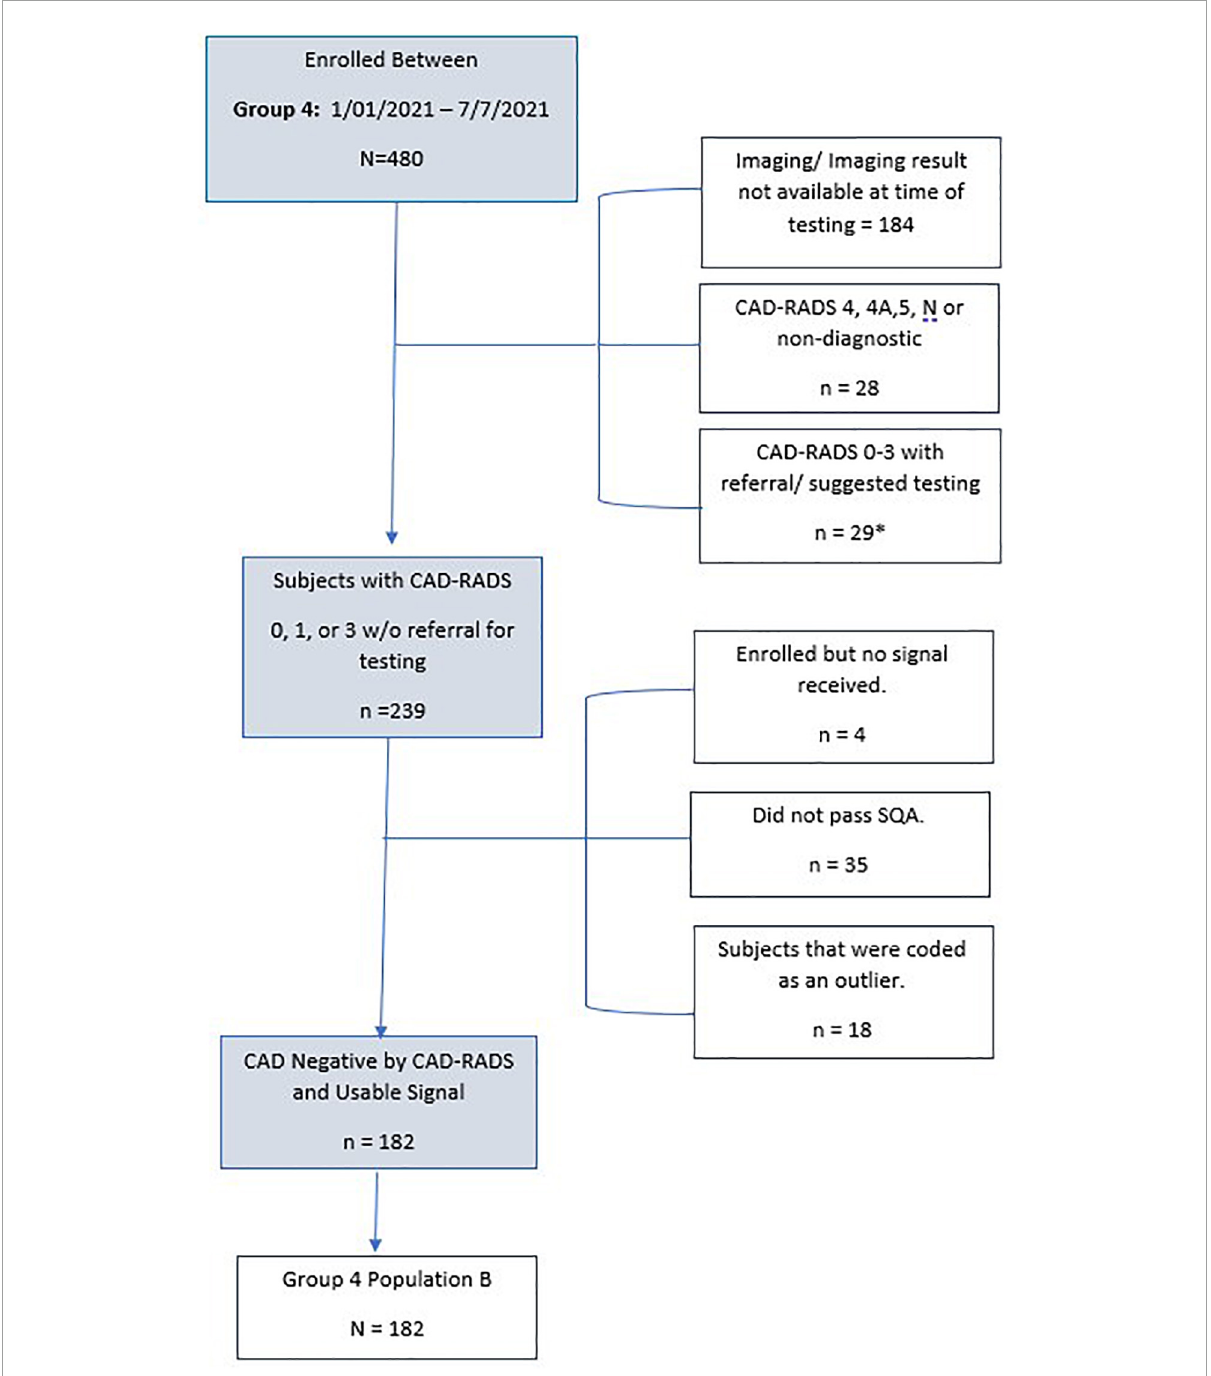
FIGURE6 Consort Diagram of Group 4 validation subjects for specificity. ∗ n = 3 with unknown treatment